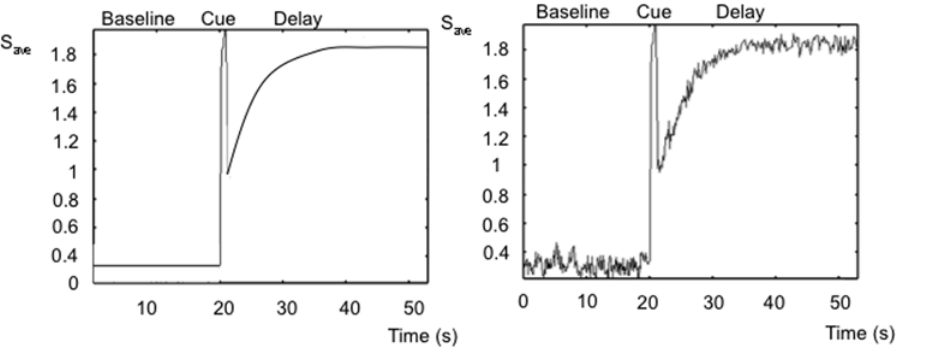
Figure 7. PSTH histogram of the single-population firing rate model (left) and the corresponding average spiking unit activity in a network of 50 units obtained from the spiking model (right). Note the general pattern is the same in both networks.